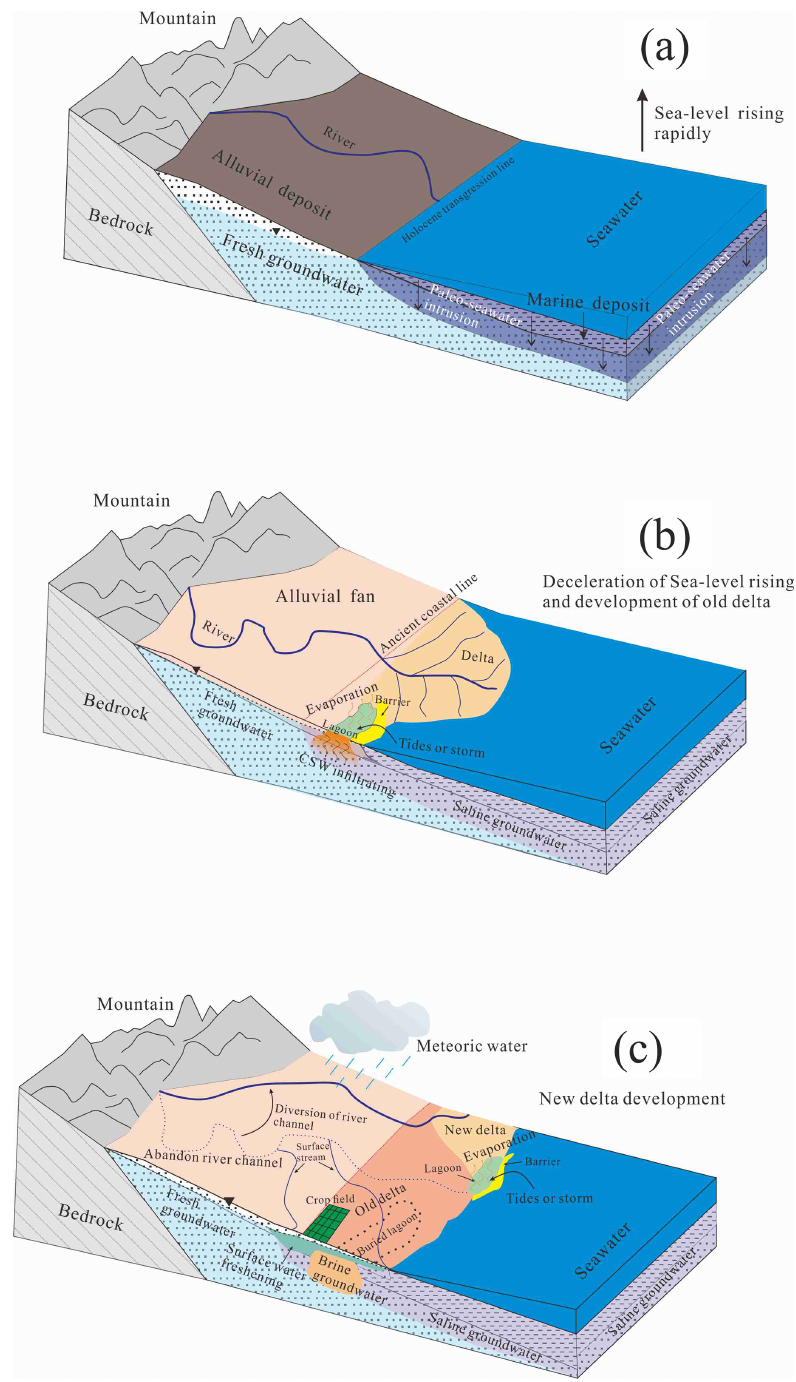
Figure 9. Diagram of paleo-environmental development during the Holocene and evolutionary pattern of saline groundwater.